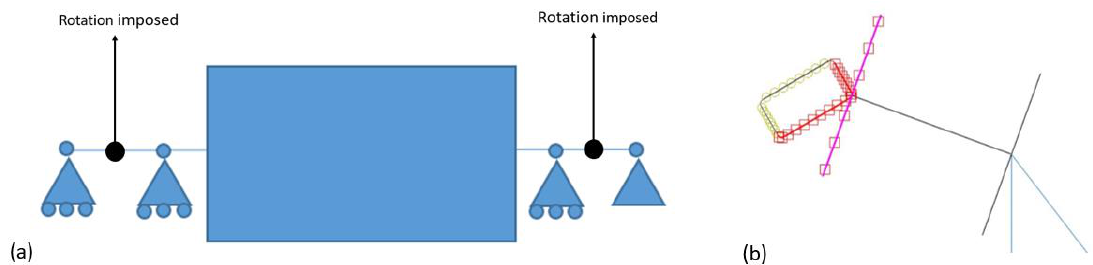
Figure 12. ( a ) Boundary conditions applied in the distributed bending, ( b ) contact interaction.